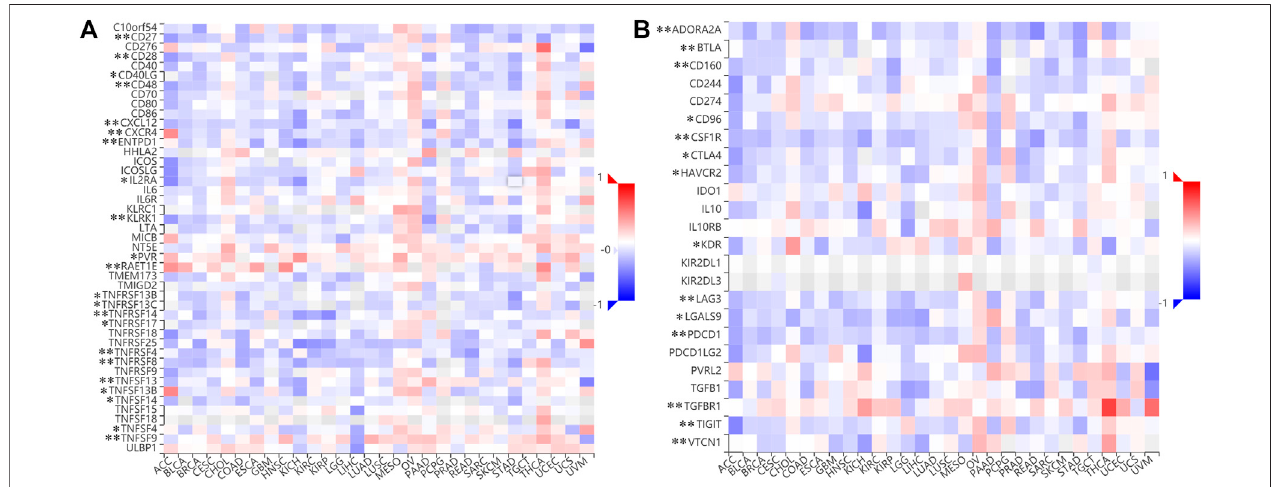
FIGURE 13 | Identi fi cation of immunomodulators associated with the MSMO1. (A) The heatmap of correlation between the immune inhibitors and the MSMO1 in CESC. (* p < 0.05; ** p < 0.01). (B) The heatmap of correlation between the immune stimulators and the MSMO1 in CESC (* p < 0.05; ** p < 0.01).